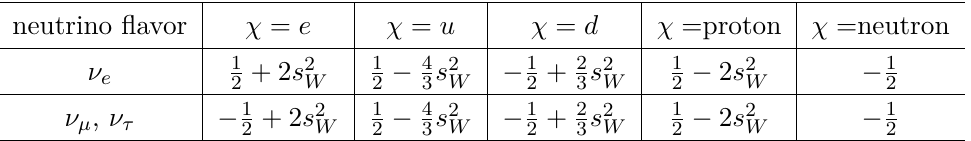
Table 1 . Values of the vector coupling g V in eq. (2.1) in the SM. Here s W ≡ sin θ W is the sine of the Weinberg